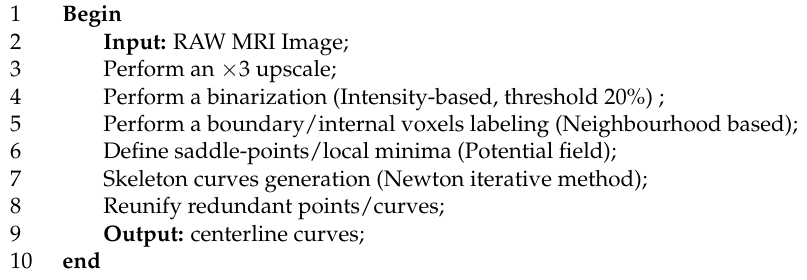
Table 2. Pseudo-code of labyrinth skeletonization method based on potential